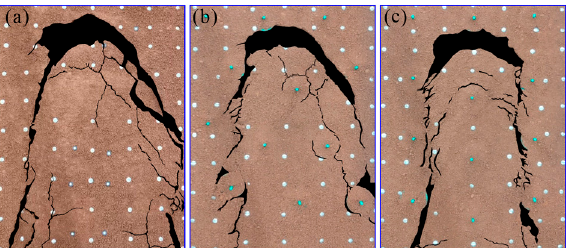
Figure 13. Slope surface cracks at the moment of 2000 s, where ( a ) set 0: unsupported slope; ( b ) set 6: slope supported by tap-like root systems in staggered pattern; ( c ) set 3: slope supported by tap-like root systems in square pattern.